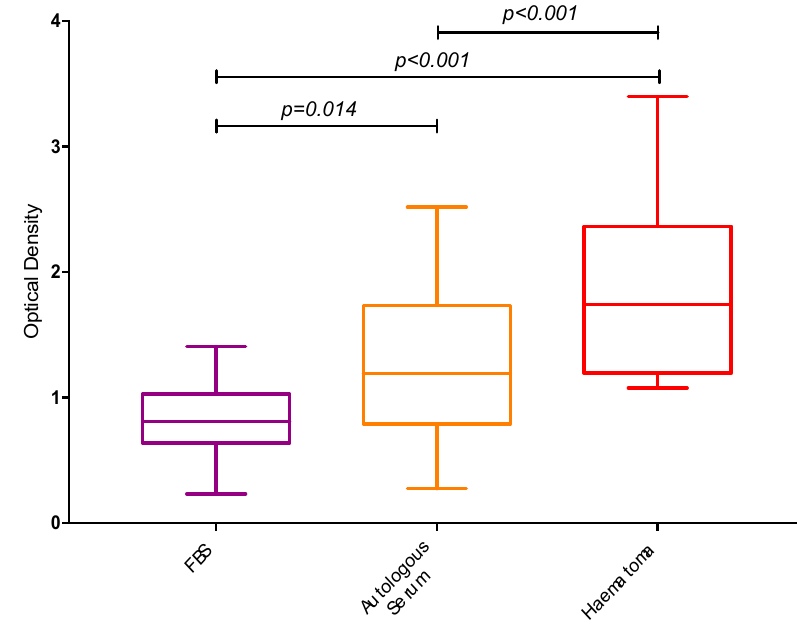
Figure 3. Box plots demonstrating the measured optical densities from the alkaline phosphatase activity colorimetric assay.